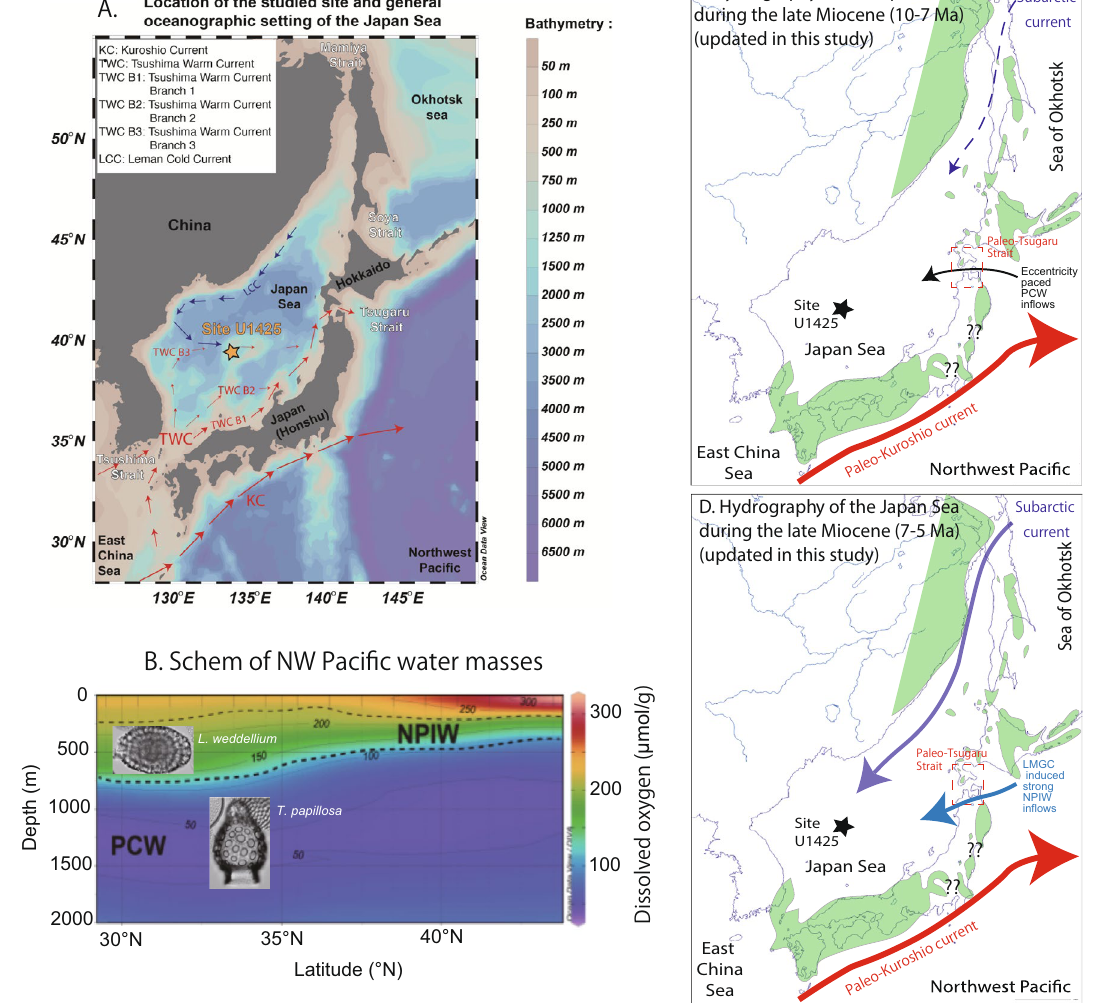
Figure 1. In the ( A ) panel, location of the Integrated Ocean Drilling Program (IODP) Expedition 346 site U1425. On the ( B ) panel, the modern oxygen distribution in the Northwest Pacific from latitude 30° N to 50° N based on the World Atlas Ocean (2018) and schematized inhabited water depths of Tricolocapsa papillosa and Larcopyle weddellium 39,44 . On the ( C , D ) panel respectively the paleoceanography of the Japan Sea reconstructed in this study between 9 and 7 Ma and 7 and 5 Ma 6 . The map in A panel and the profile in B panel was generated using Ocean Data View 4 62 Version 5.1.0 available at https:// odv. awi. de/ softw are/ downl